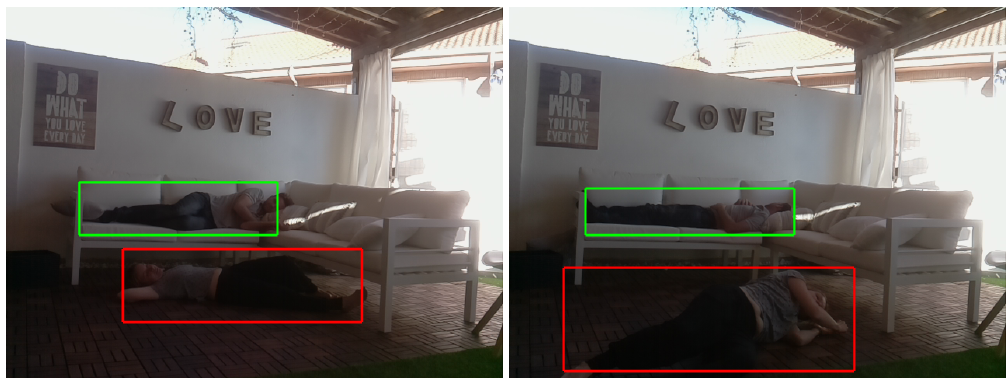
Figure 12. Example images from testing test where algorithm differentiates between fallen person and resting person.